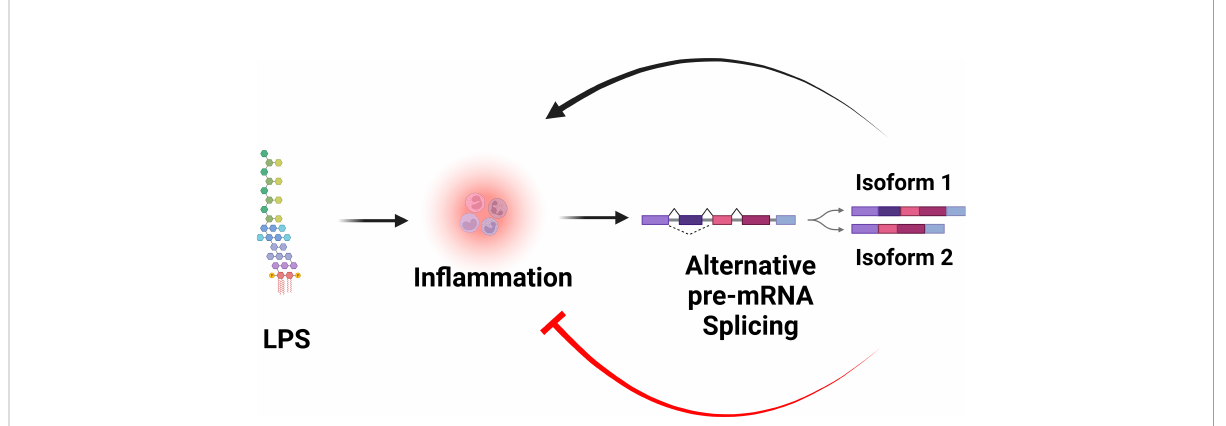
FIGURE 3 Alternative pre-mRNA splicing mediates a negative feedback loop that limits in fl ammation. LPS stimulation is sensed by the TLR4 signaling pathway, which induces in fl ammation. LPS stimulation also alters pre-mRNA splicing of many genes in the TLR4 signaling pathway, leading to the production of splice forms that encode negative regulators that inhibit in fl ammation. Figure created with